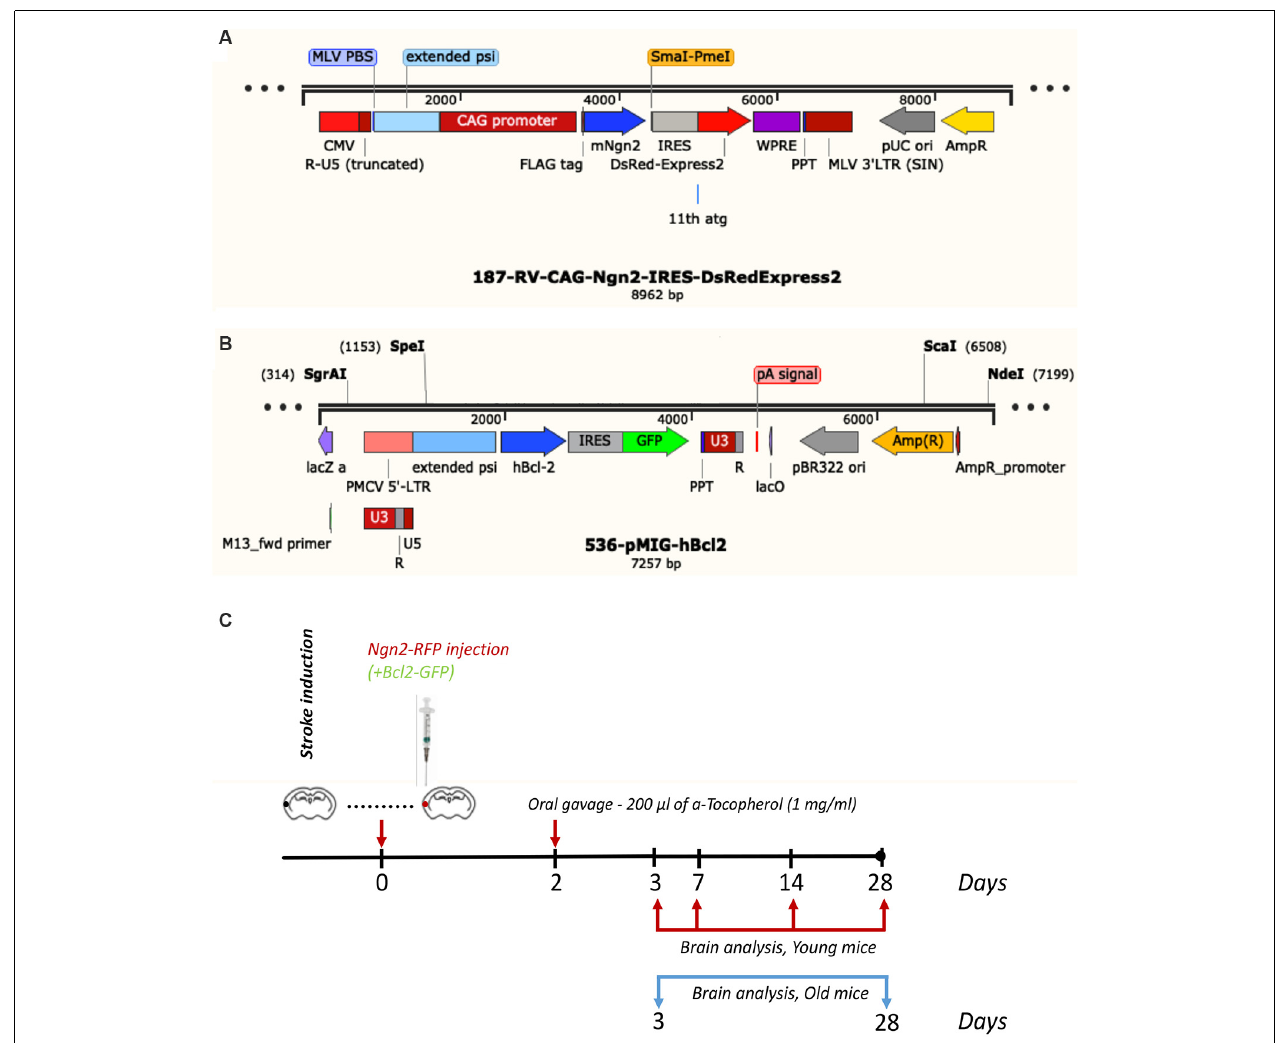
FIGURE 1 | Viral constructs (A,B) and experimental design (C)